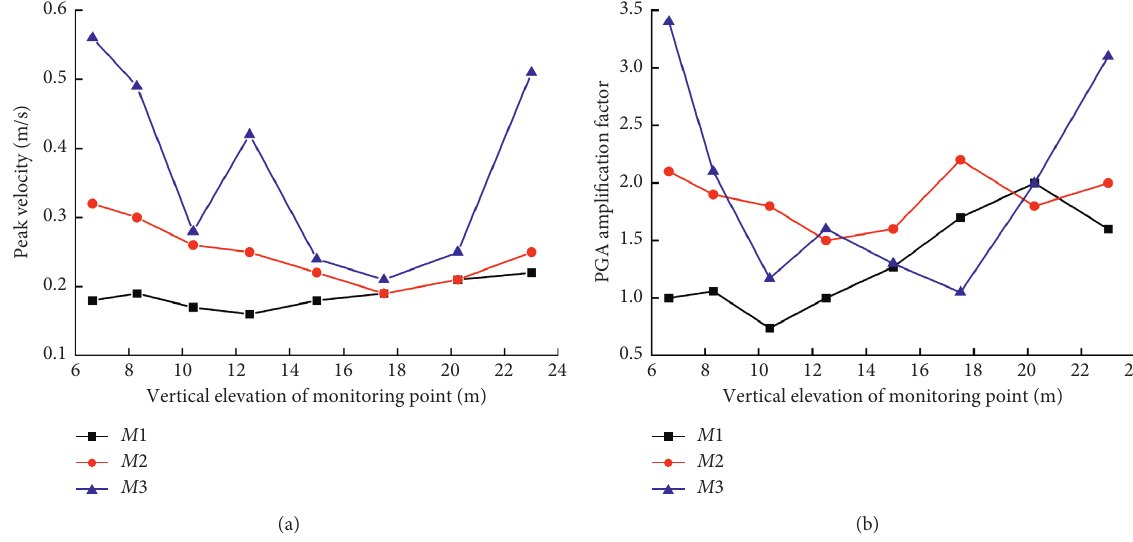
Figure 11: Distribution of peak velocity and PGA amplification coefficient at the monitoring point of A chain joint surface. (a) Peak velocity. (b) PGA amplification coefficient.